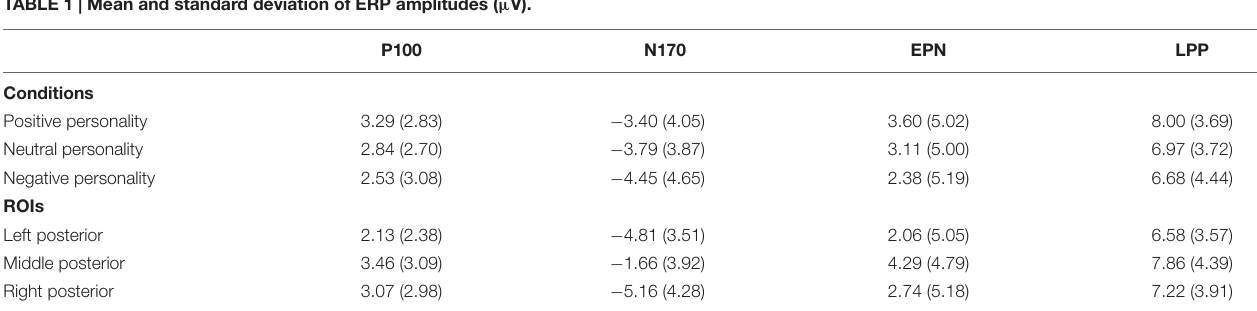
FIGURE 3 | Grand Averages at posterior sites for faces of varying personalities. Pos, positive personality; Neu, neutral personality; Neg, negative personality. TABLE 1 | Mean and standard deviation of ERP amplitudes ( µ